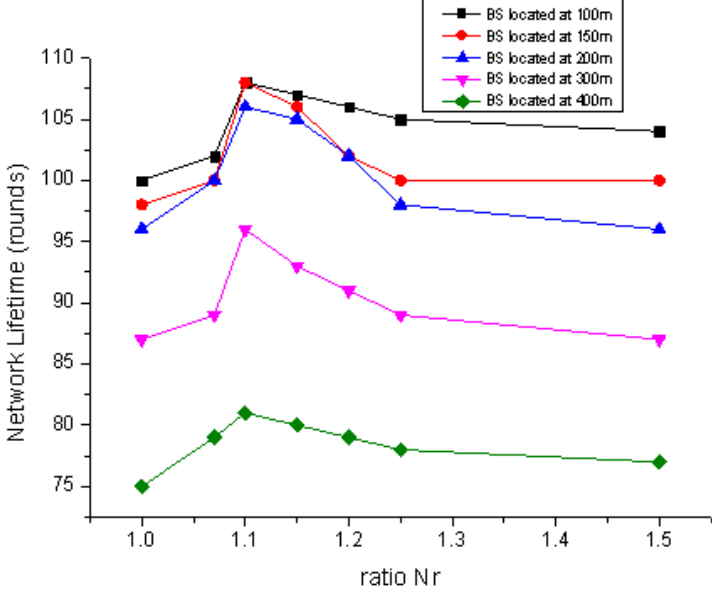
Figure 7. First node depletion time in rounds versus N 200 m, 300 m and 400 m away from the center of the network